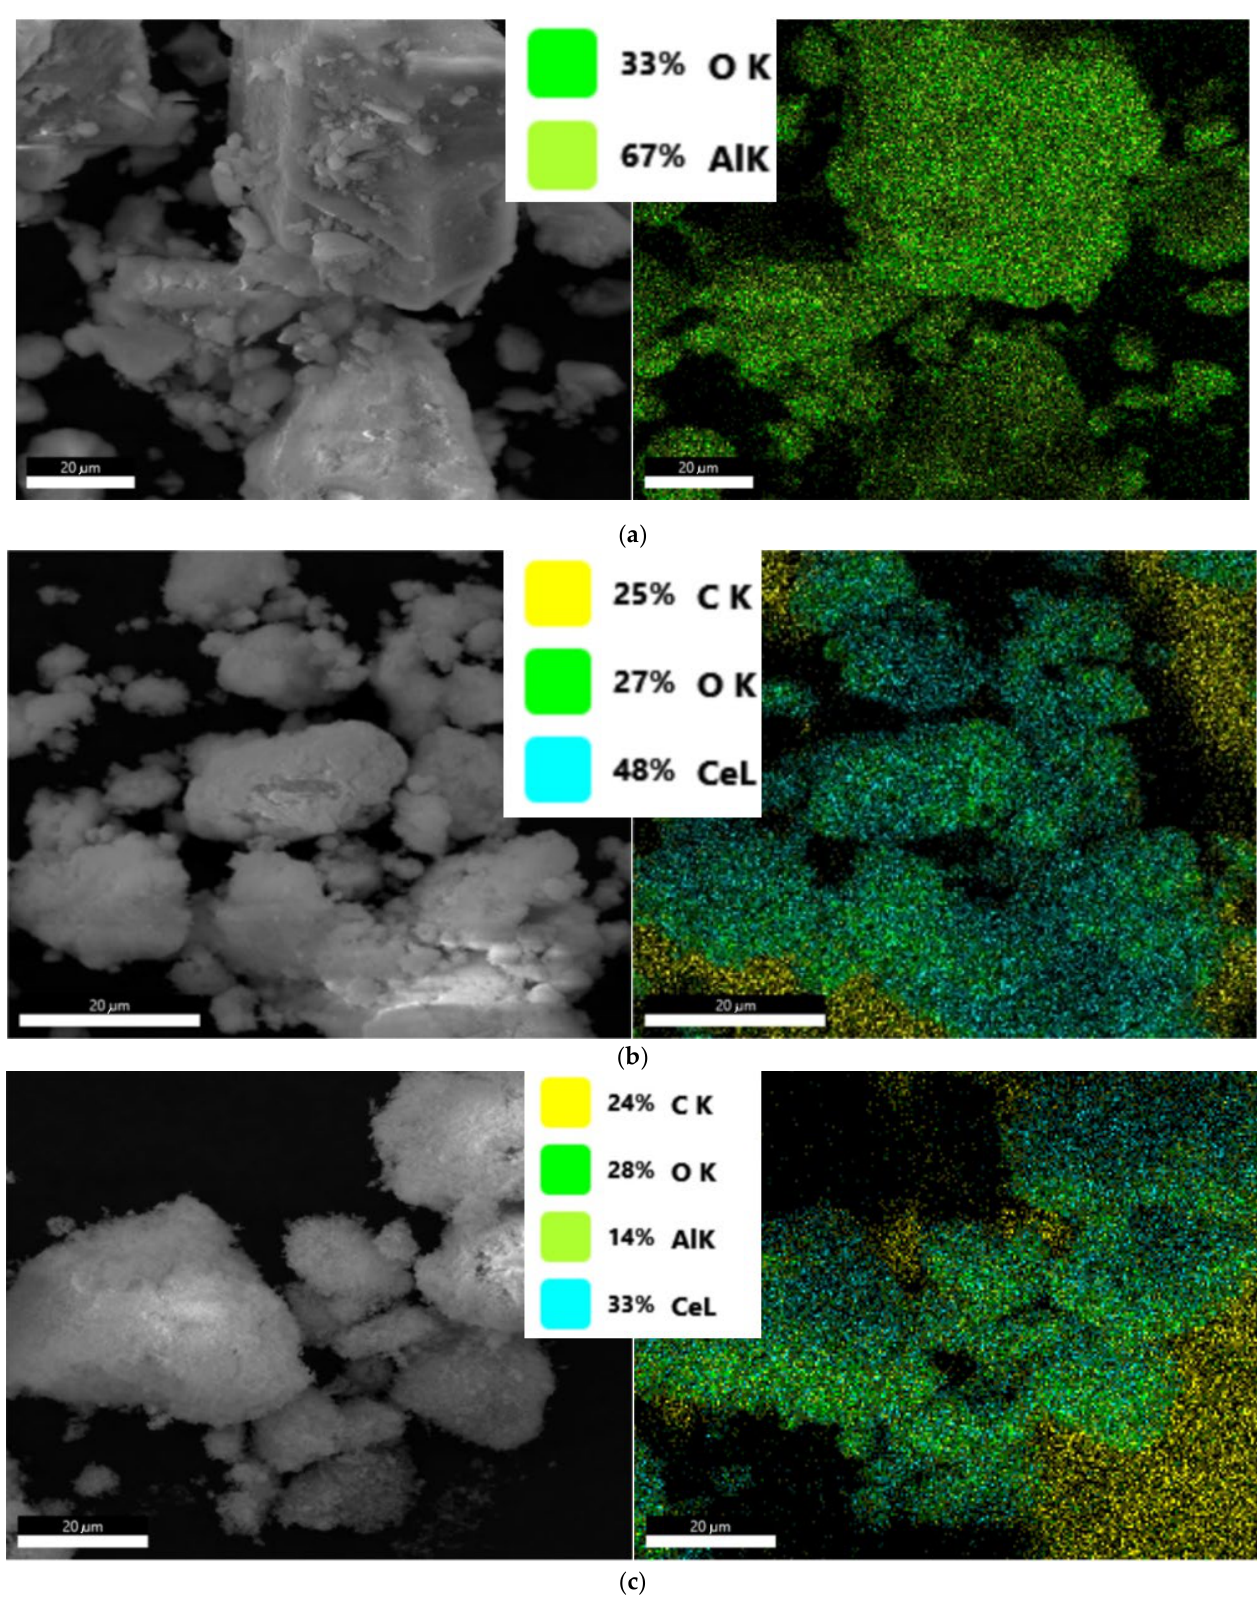
Figure 2. SEM micrographs and EDS of ( a ) Al 2 O 3 , ( b ) CeO 2 , and ( c ) AlCeO 3 nanopowders. The samples imaged by transmission electron microscopy for the Al 2 O 3 , CeO 2 , and AlCeO 3 are shown in Figure 3a–c, respectively. The TEM images confirm the formation of